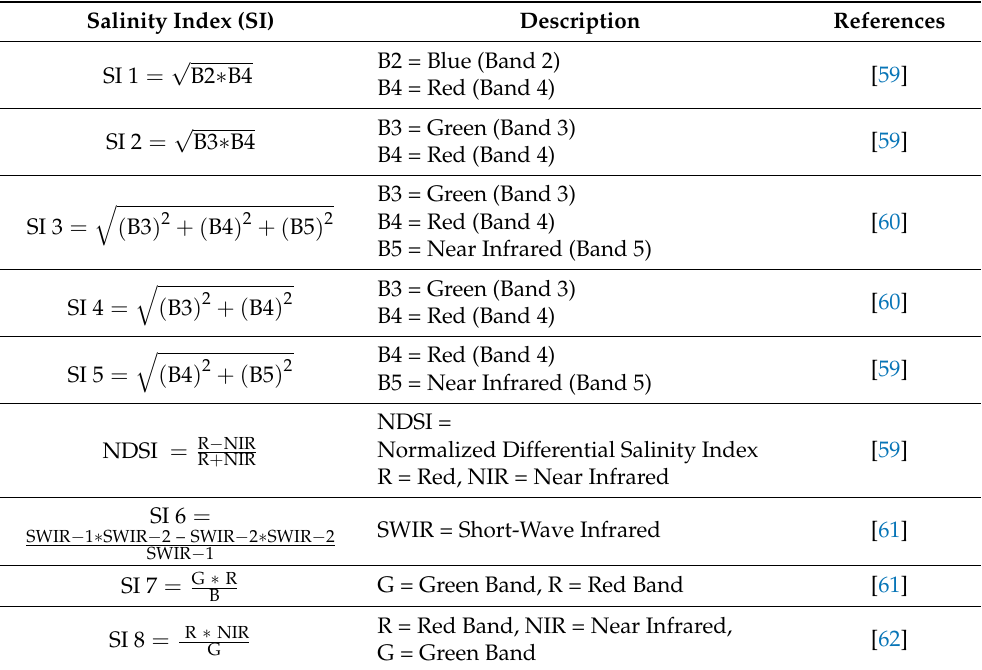
Table 4. Various Salinity Indices (SI) used to develop soil salinity